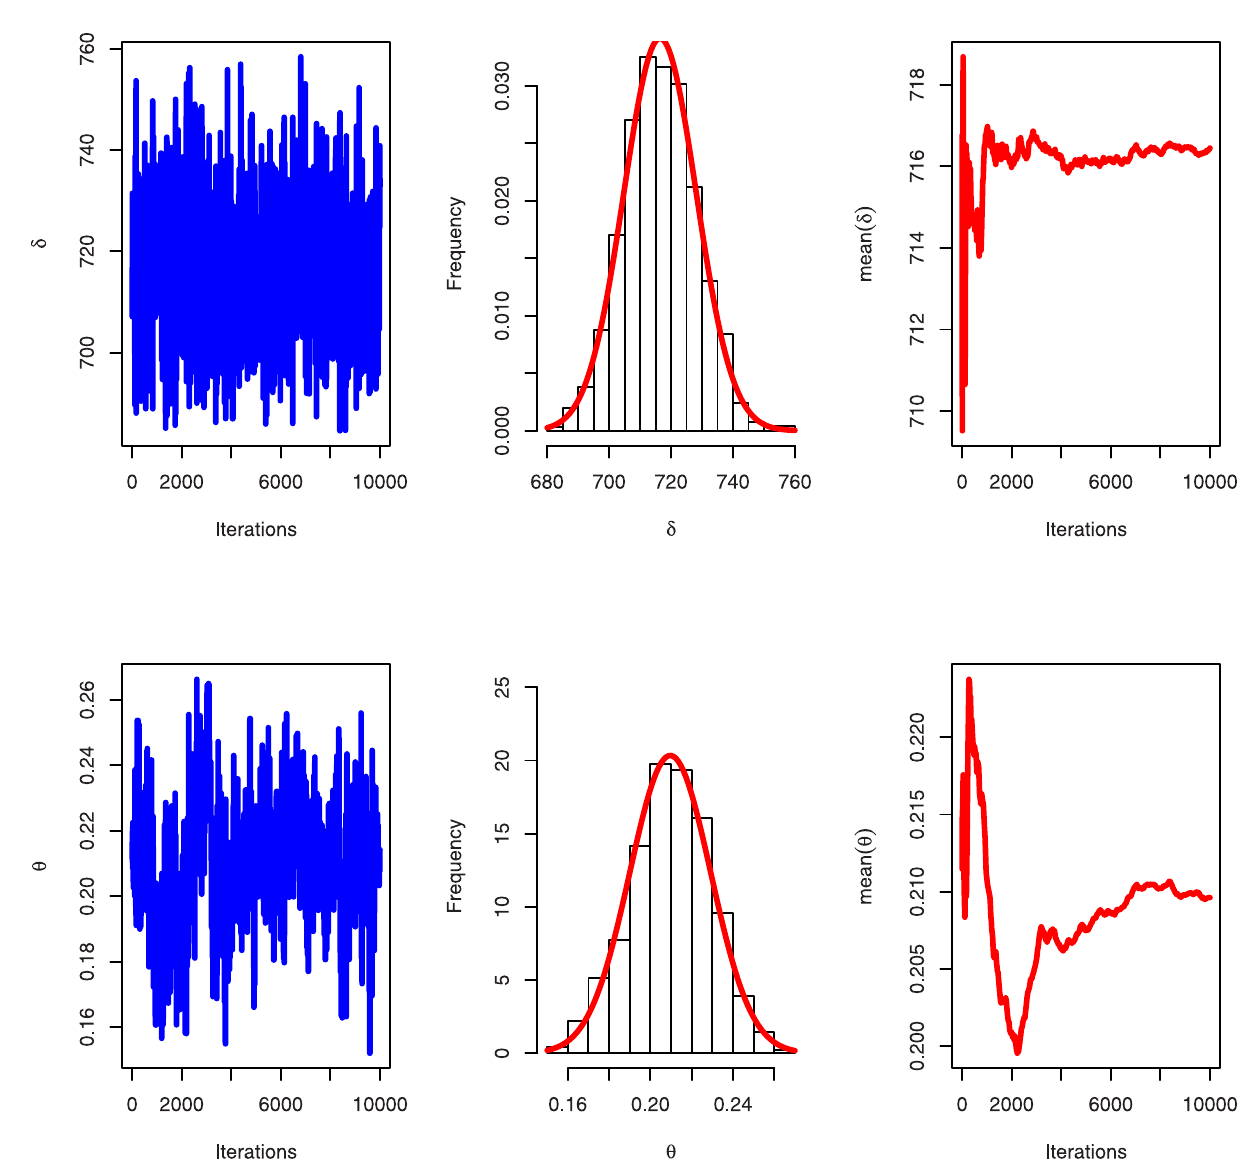
Fig 12. Convergence of MCMC estimation of OLINH distribution for COVID-19 vaccination for the parameters δ , and θ